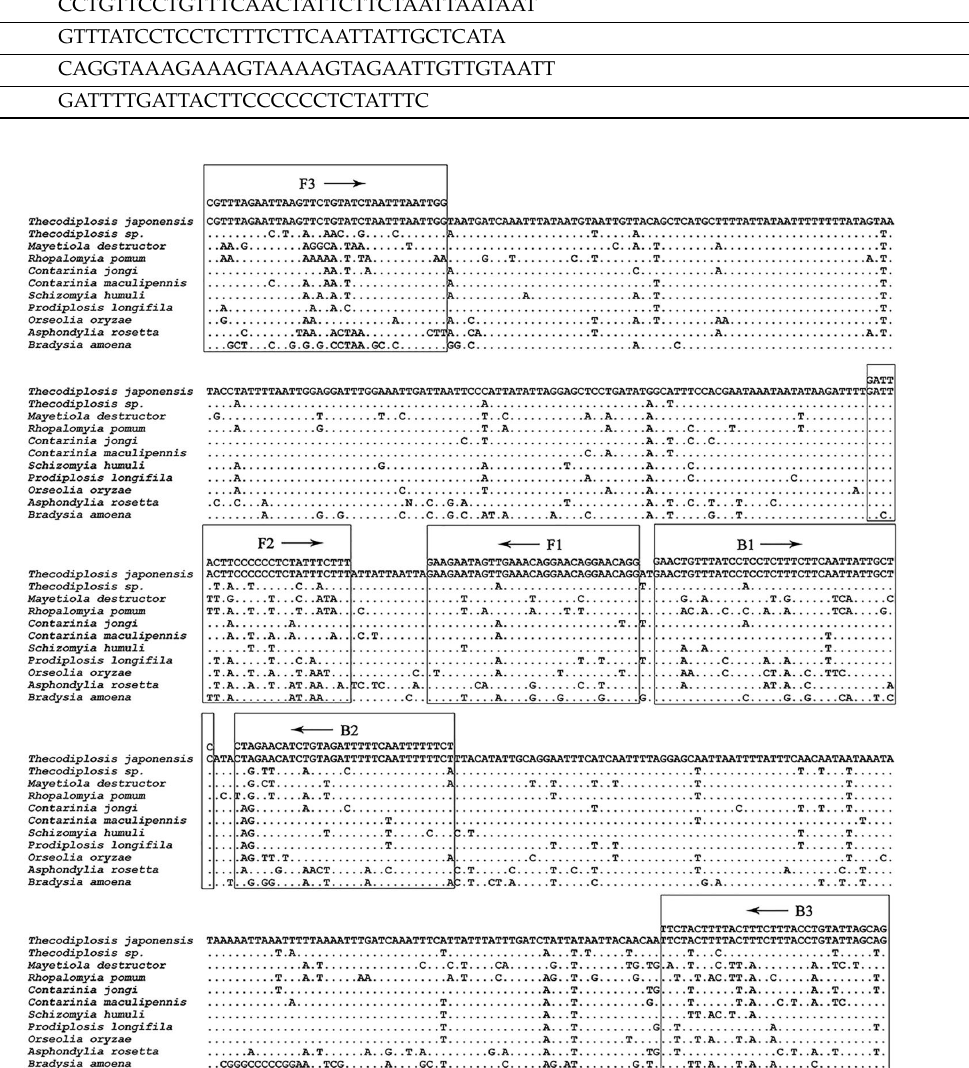
Figure 2. Alignment of COI gene sequences of T. japonensis with related gall midges. Primer regions are marked with boxes. FIP is composed of the reverse complement of F1 and F2; BIP is composed of B1 and the reverse complement of B2.